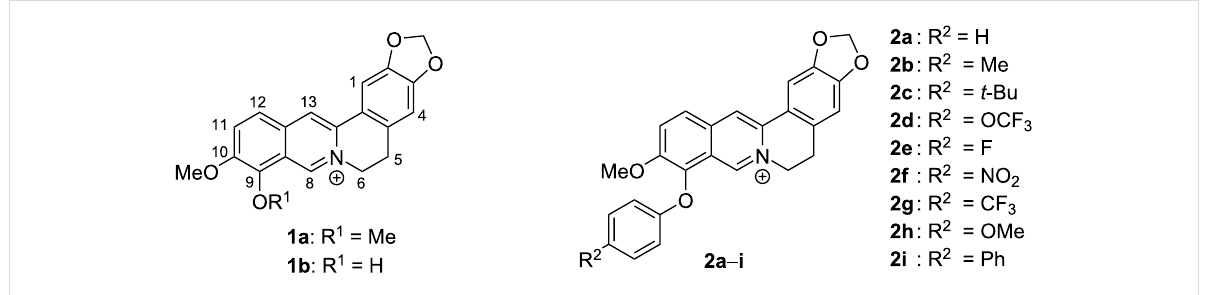
Figure 1: Structures and numbering of berberine ( 1a ), berberrubine ( 1b ) and 9- O -aryl-substituted berberine derivatives 2a – i